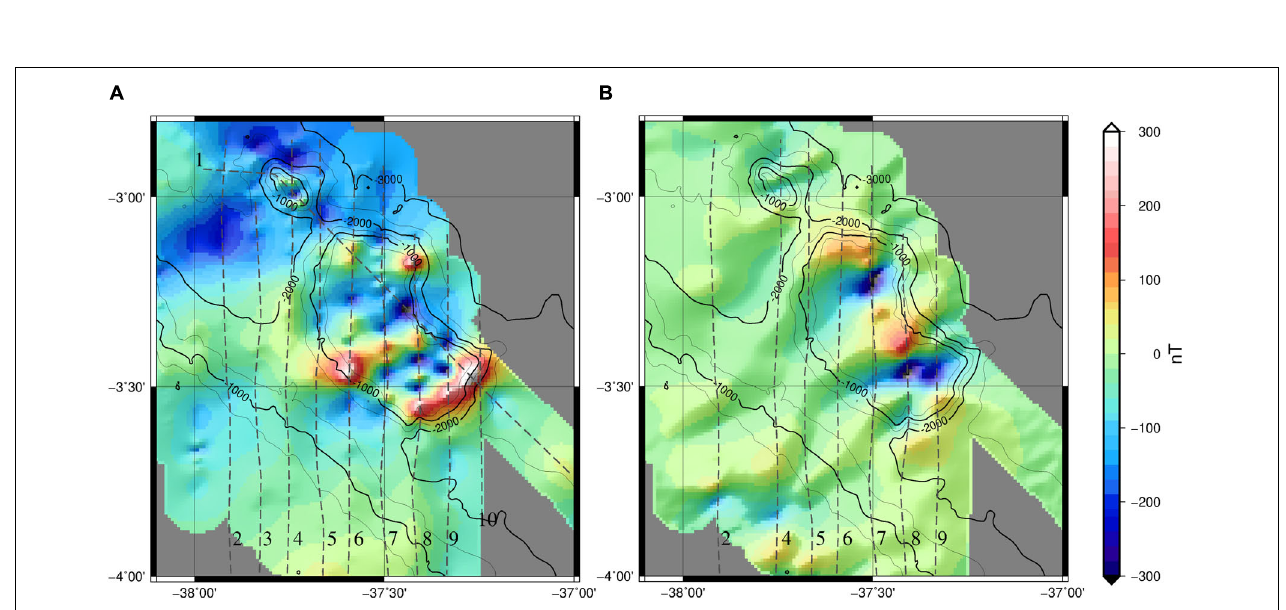
FIGURE 8 | Magnetic anomaly maps. (A) Observed data and (B) modeled anomalies calculated with 3 km layer below the basement surface. Dashed profiles #1 to #10 shows the position of bathymetric, gravity and magnetic marine survey, the red line shows the position of the seismic profile of Figure 2 . Grid interval of 30 s (approximately 900 m). Bathymetric contours shown at 500 m